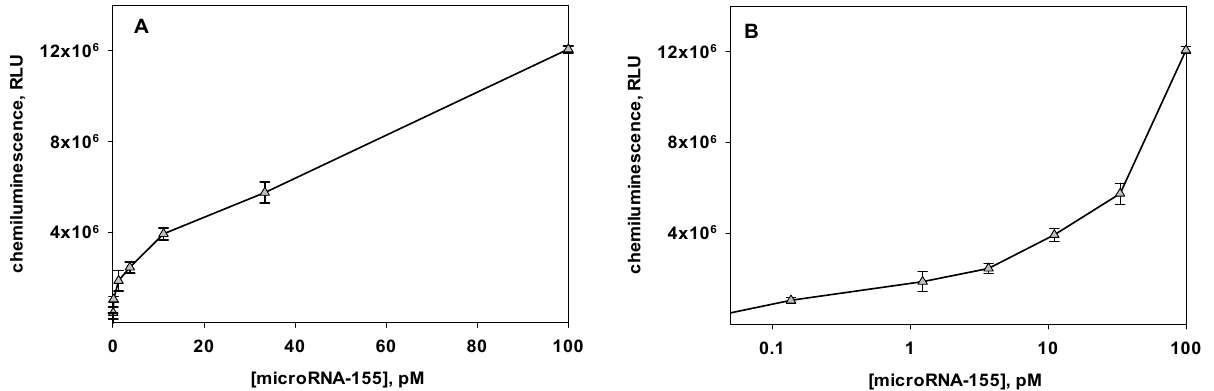
Figure 6. Calibration curve for the determination of microRNA-155 by the chemiluminescent het- erogenous assay based on mismatched catalytic hairpin assembly amplification (n = 6) presented in ( A ) linear and ( B ) semi-logarithmic coordinates.